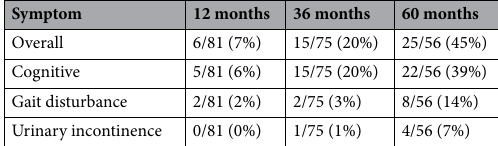
Table 3. Number of patients who developed symptoms after 12 months, 36 months, and 60 months following radiotherapy.